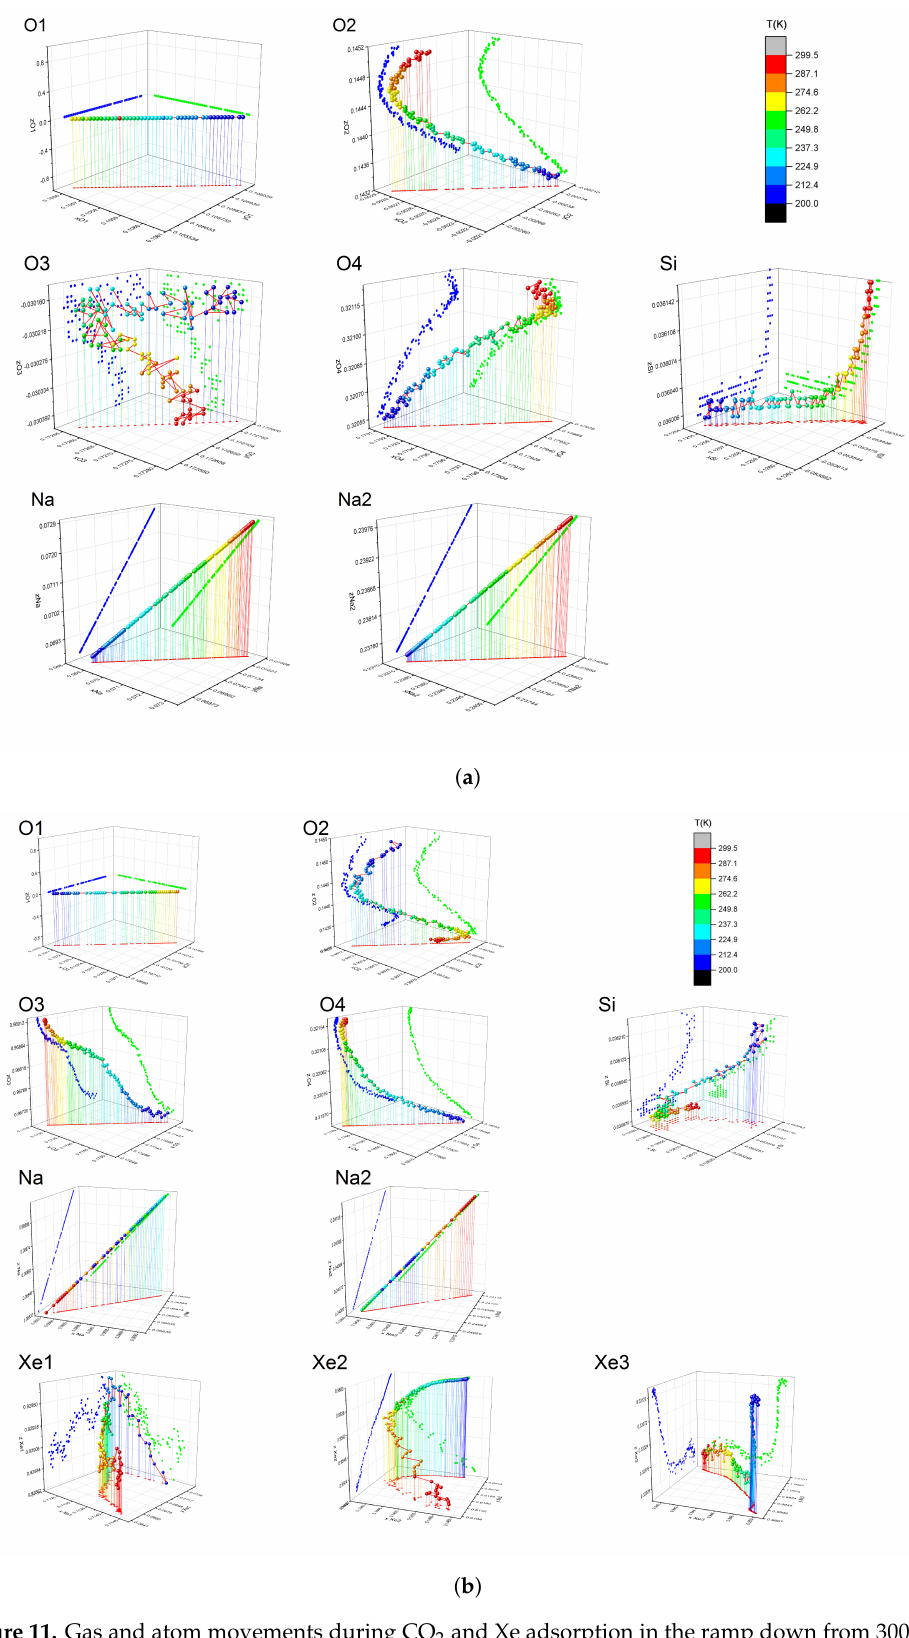
Figure 11. Gas and atom movements during CO 2 and Xe adsorption in the ramp down from 300 K to 200 K. ( a ) Atom movements during CO 2 adsorption. ( b ) Atom movements during Xe adsorption.